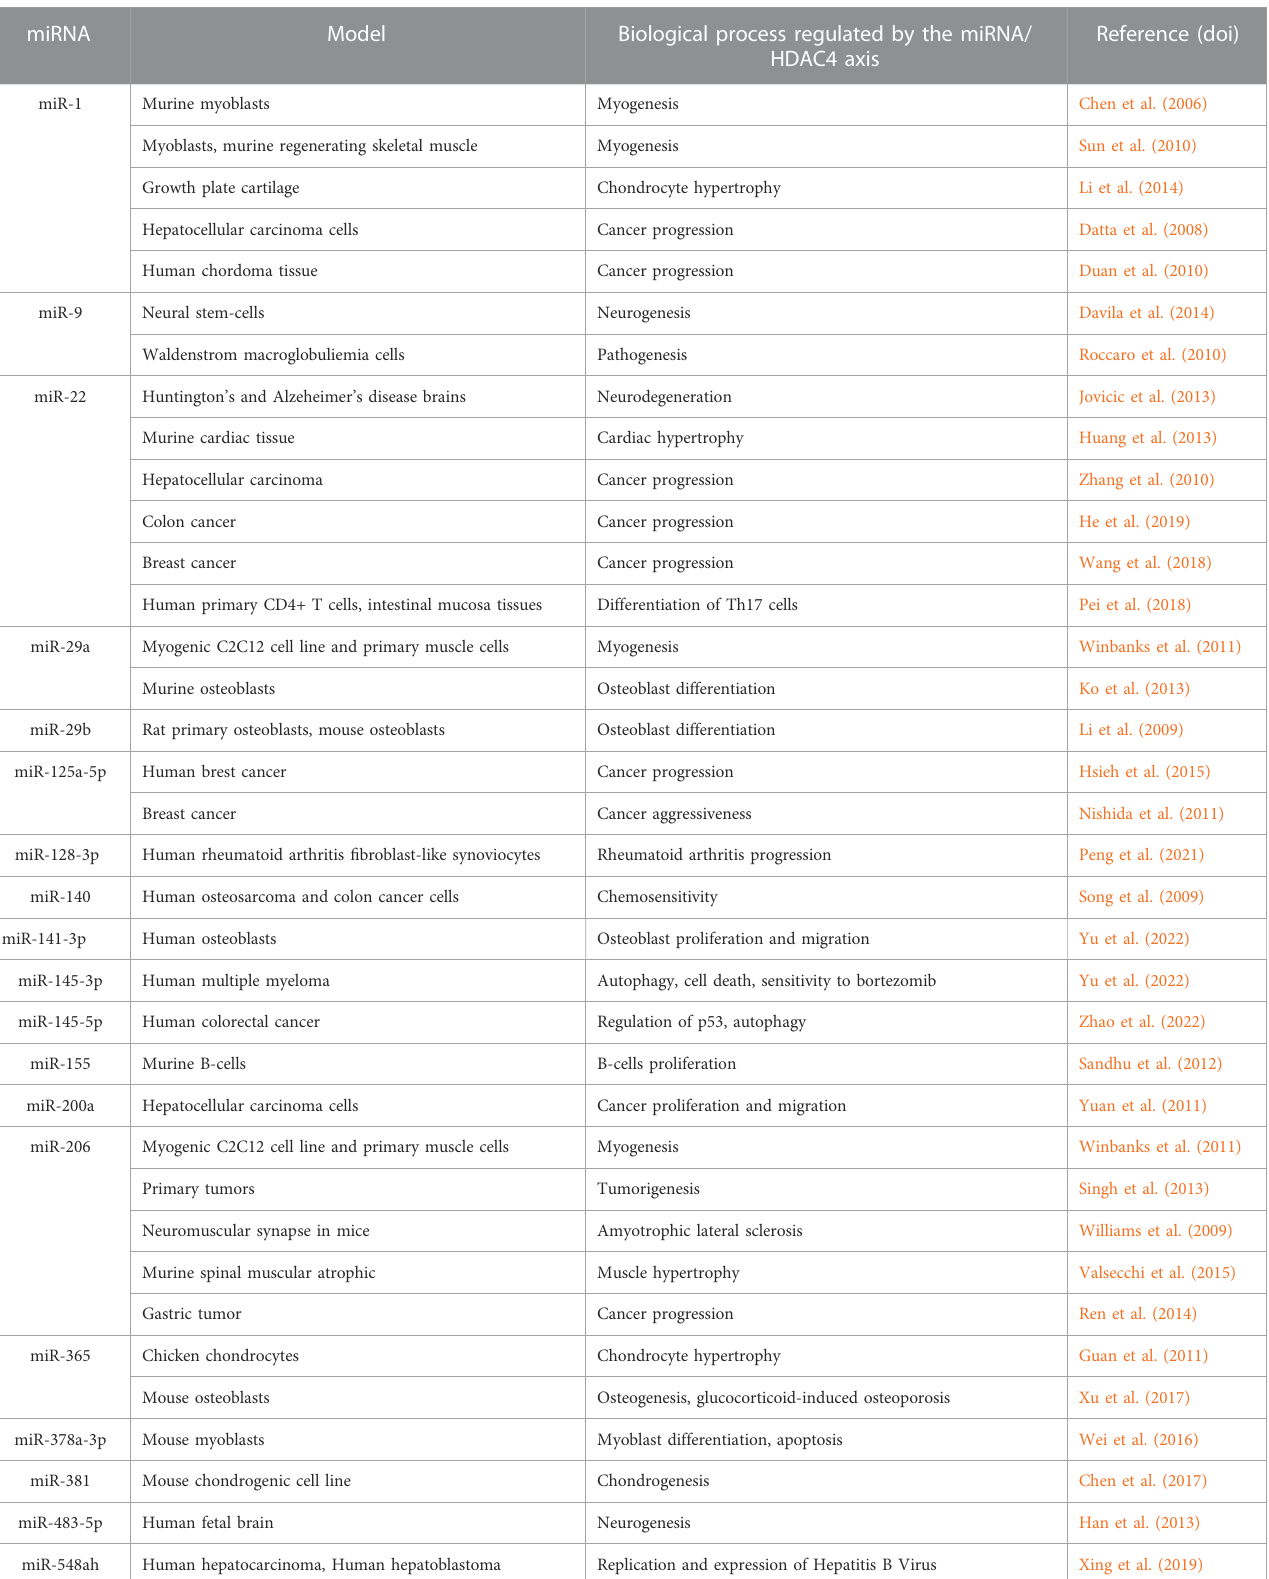
TABLE 4 List of miRNAs in fl uencing HDAC4 levels. miRNA